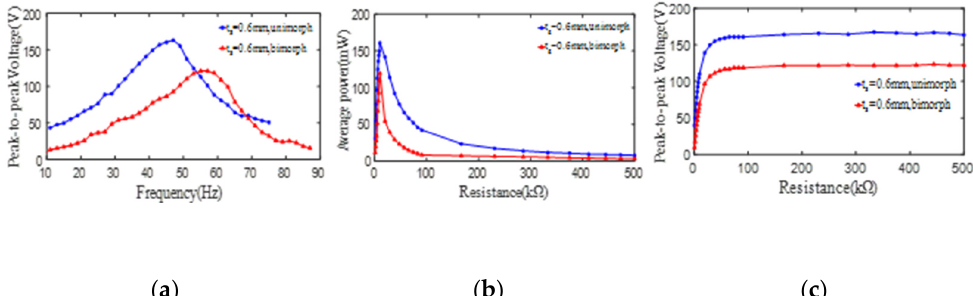
Figure 9. The effect of unimorph PCD and bimorph PCD on the peak-to-peak voltage and average power of one PZT4 patch ( t s = 0.6 mm). ( a ) peak-to-peak voltage versus excitation frequency; ( b ) average power versus load resistance; ( c ) peak-to-peak voltage versus load resistance.